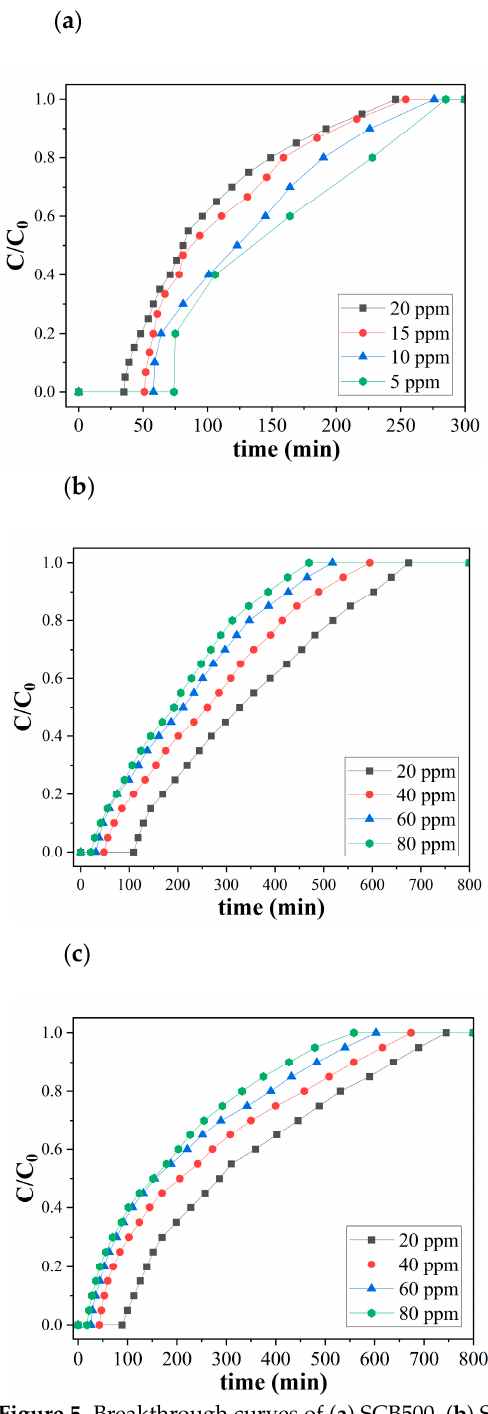
Figure 5. Breakthrough curves of ( a ) SCB500, ( b ) SCB550-Fe, and ( c ) SCB550-Mn (RH = 35%, temperature = 23 °C, retention time = 0.47 s, and packing density = 0.03 g/cm 3 ).